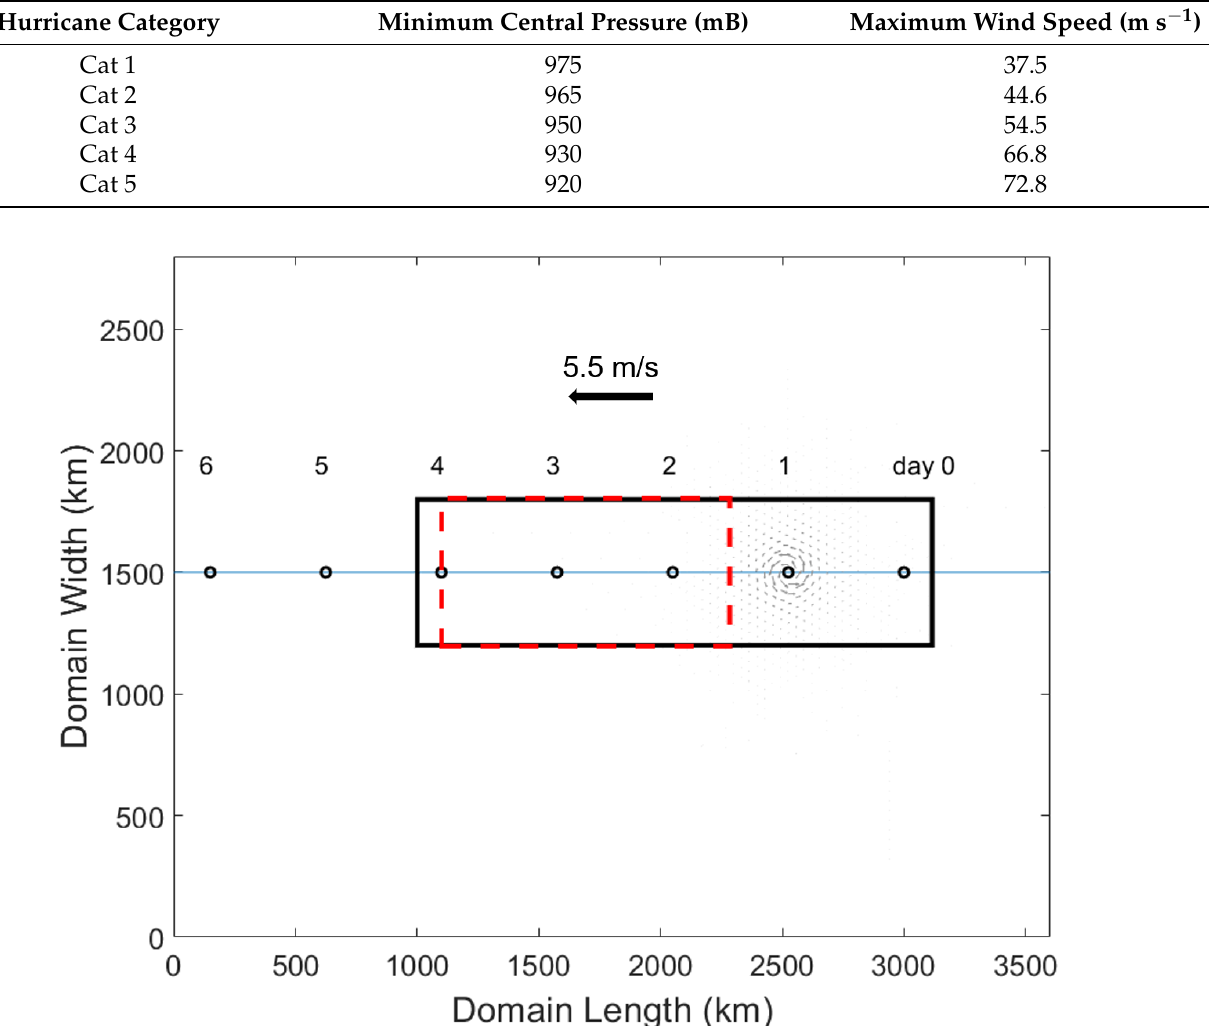
Figure 1. The ROMS model domain, 3600 km by 2800 km. Black circles denote the location of the control run hurricane’s center at the beginning of the day labeled above it. The black rectangle shows the averaged area used in Figure 2, while the dashed red rectangle shows the zonally averaged area used in Figure 3. Grey vectors indicate the hurricane wind field, and the hurricane direction with the control run’s translation speed is